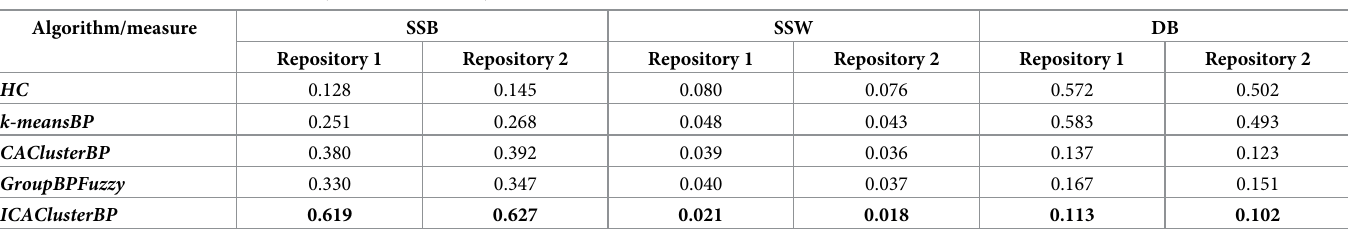
Table 4. Results of internal evaluation (best results in